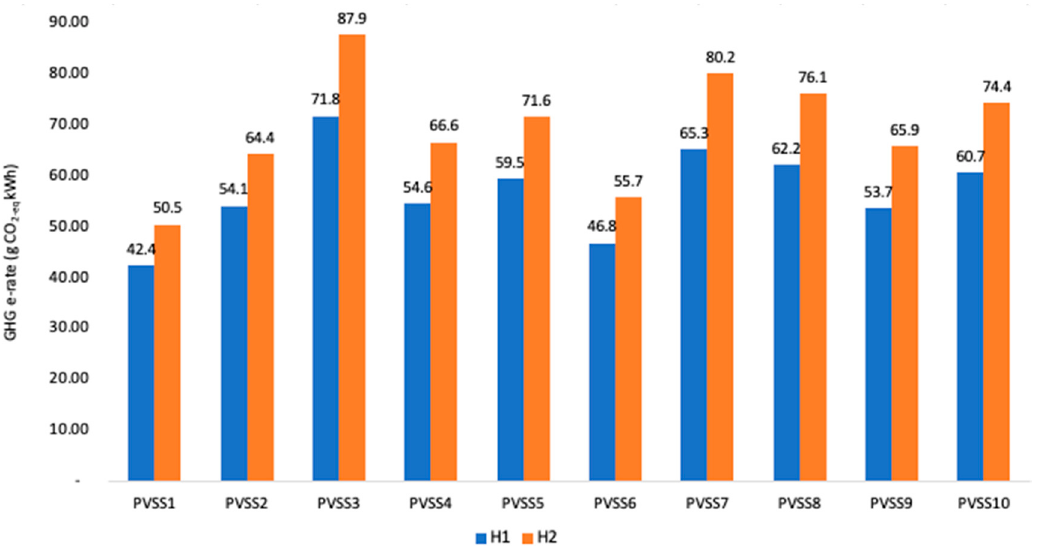
Figure 9. Comparison of the GHG emission results for different assumptions of the national grid emission factor. In this direction, Figure 10 shows a comparison between payback emission time for different hypotheses adopted for national emission factors. H1 and H2 show the emission factors according to different sources of data as discussed in Figure 10 above.